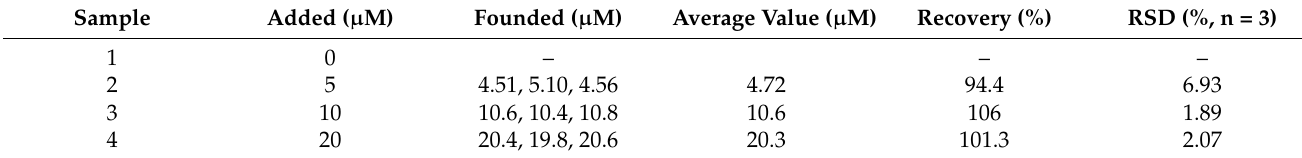
Table 2. Detection of carbaryl in lettuce juice by electrochemical carbaryl